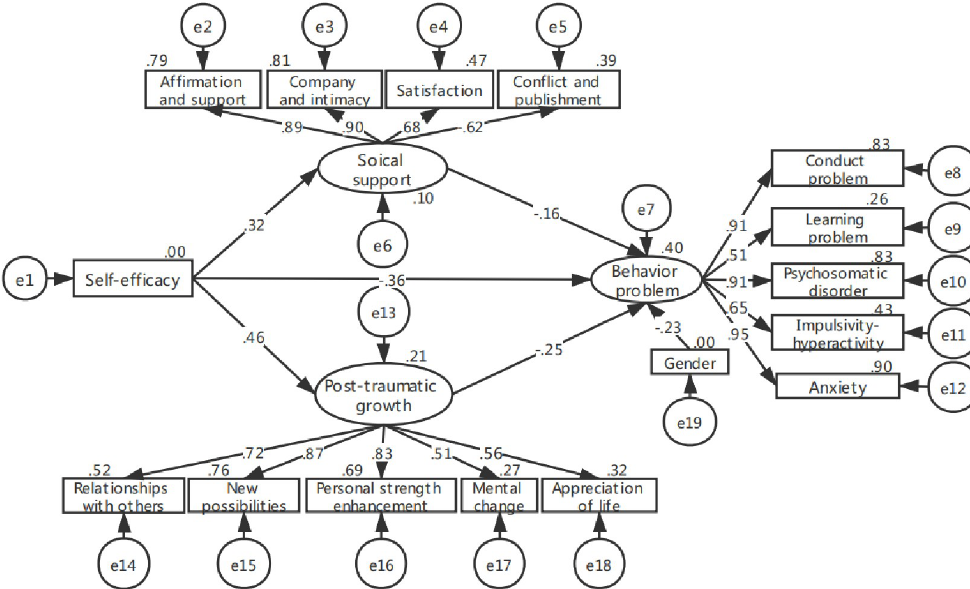
Fig 1. The first model of behavior problems among 8~18 years old children with malignant